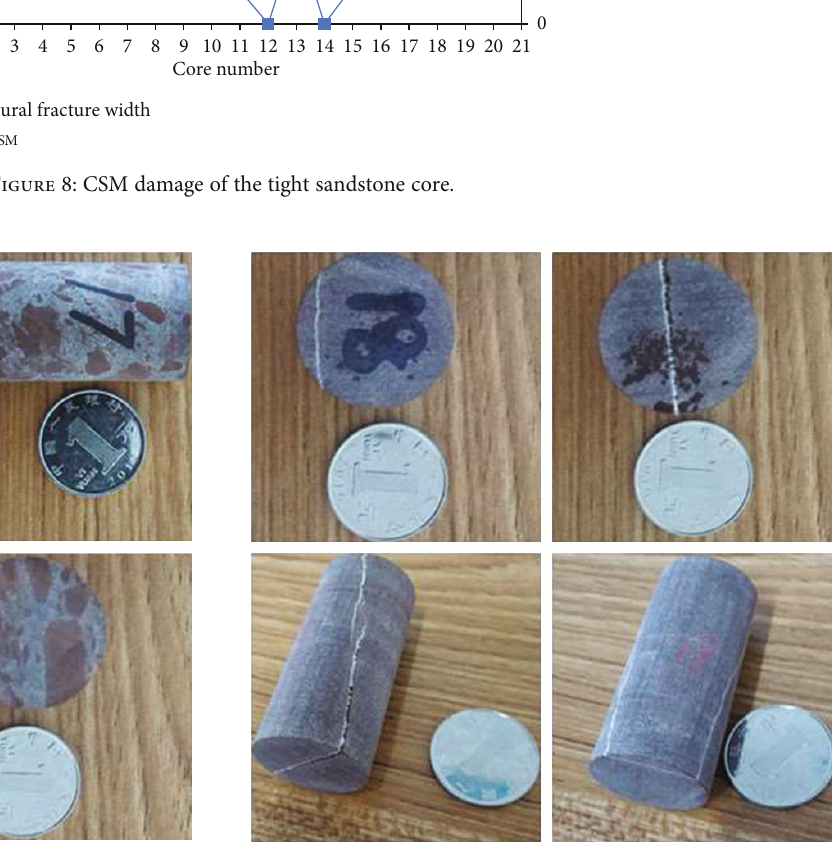
Figure 9: No. 17 tight sandstone core (rock matrix). Figure 10: No. 18 tight sandstone core (naturally